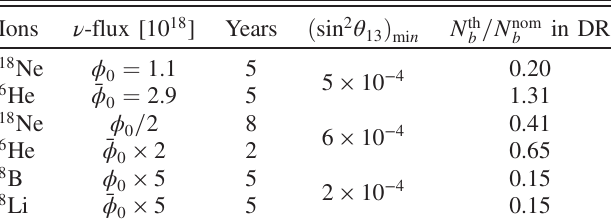
TABLE XV. The first four columns show the ion pair, assumed yearly neutrino fluxes, number of years for run and the θ 13 sensitivities, from [98]. The fifth column shows single bunch ion intensity limit compared to nominal intensity necessary for the neutrino fluxes in the 2nd column. These results are based on transverse resonance broadband impedance studies for the DR (assuming R ⊥ ¼ 1 M Ω =